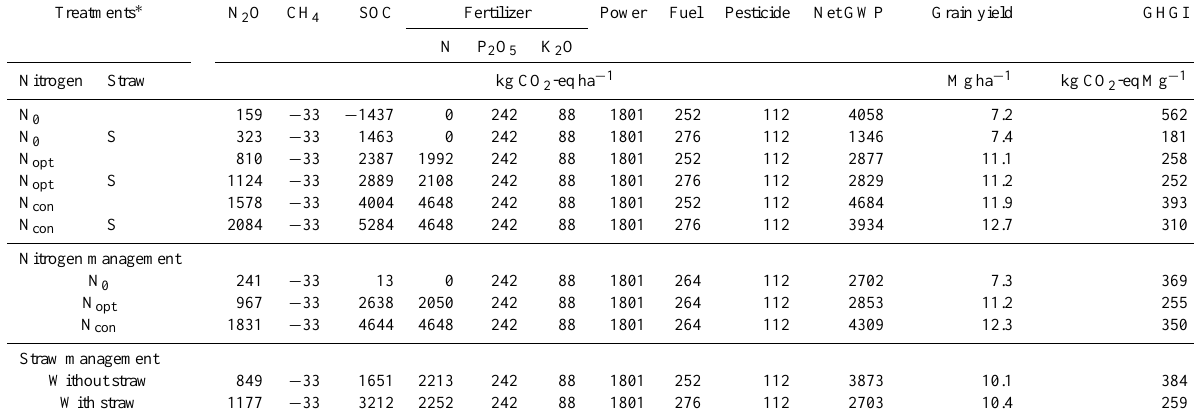
Table 6. Net global warming potential (NGWP) and greenhouse gas intensity (GHGI) in winter wheat–summer maize double-cropping system from June 2011 to June